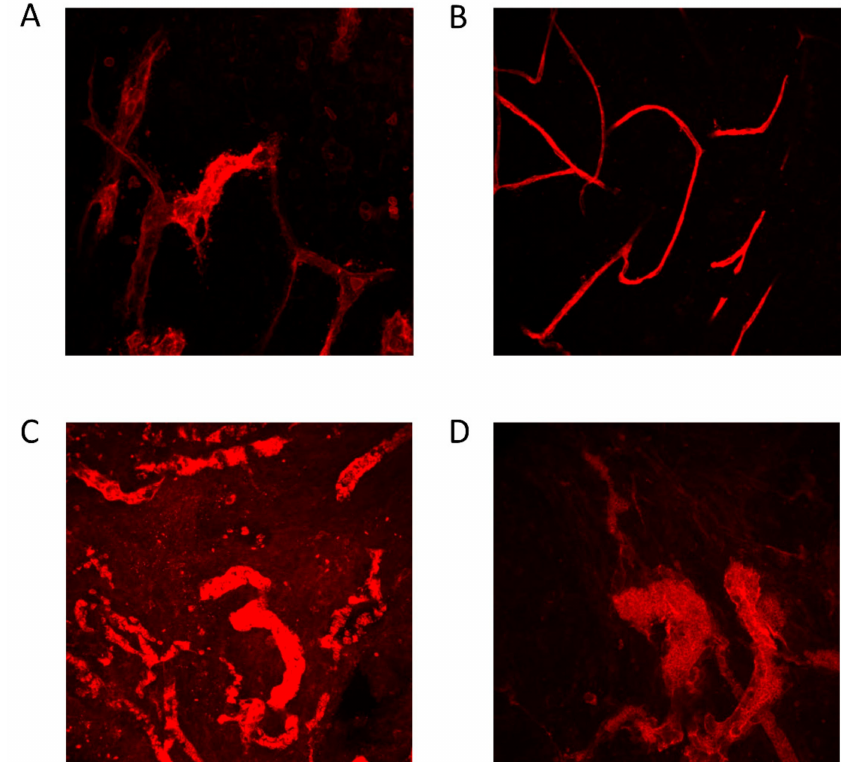
Figure 7. Comparison in blood vessel width (Glut1) between high-grade serous ovarian cancer (HGSOC) and low-grade serous ovarian cancer (LGSOC) ( A , B ) and between primary and metastatic tumor ( C , D ). (a) Primary tumor biopsy of a stage IIIC HGSOC. ( B ) Primary tumor biopsy of a stage IIIC LGSOC. ( C ) Primary tumor biopsy of HGSOC stage IIIC (di ff erent patient than ( A )). ( D ) Metastatic tumor biopsy